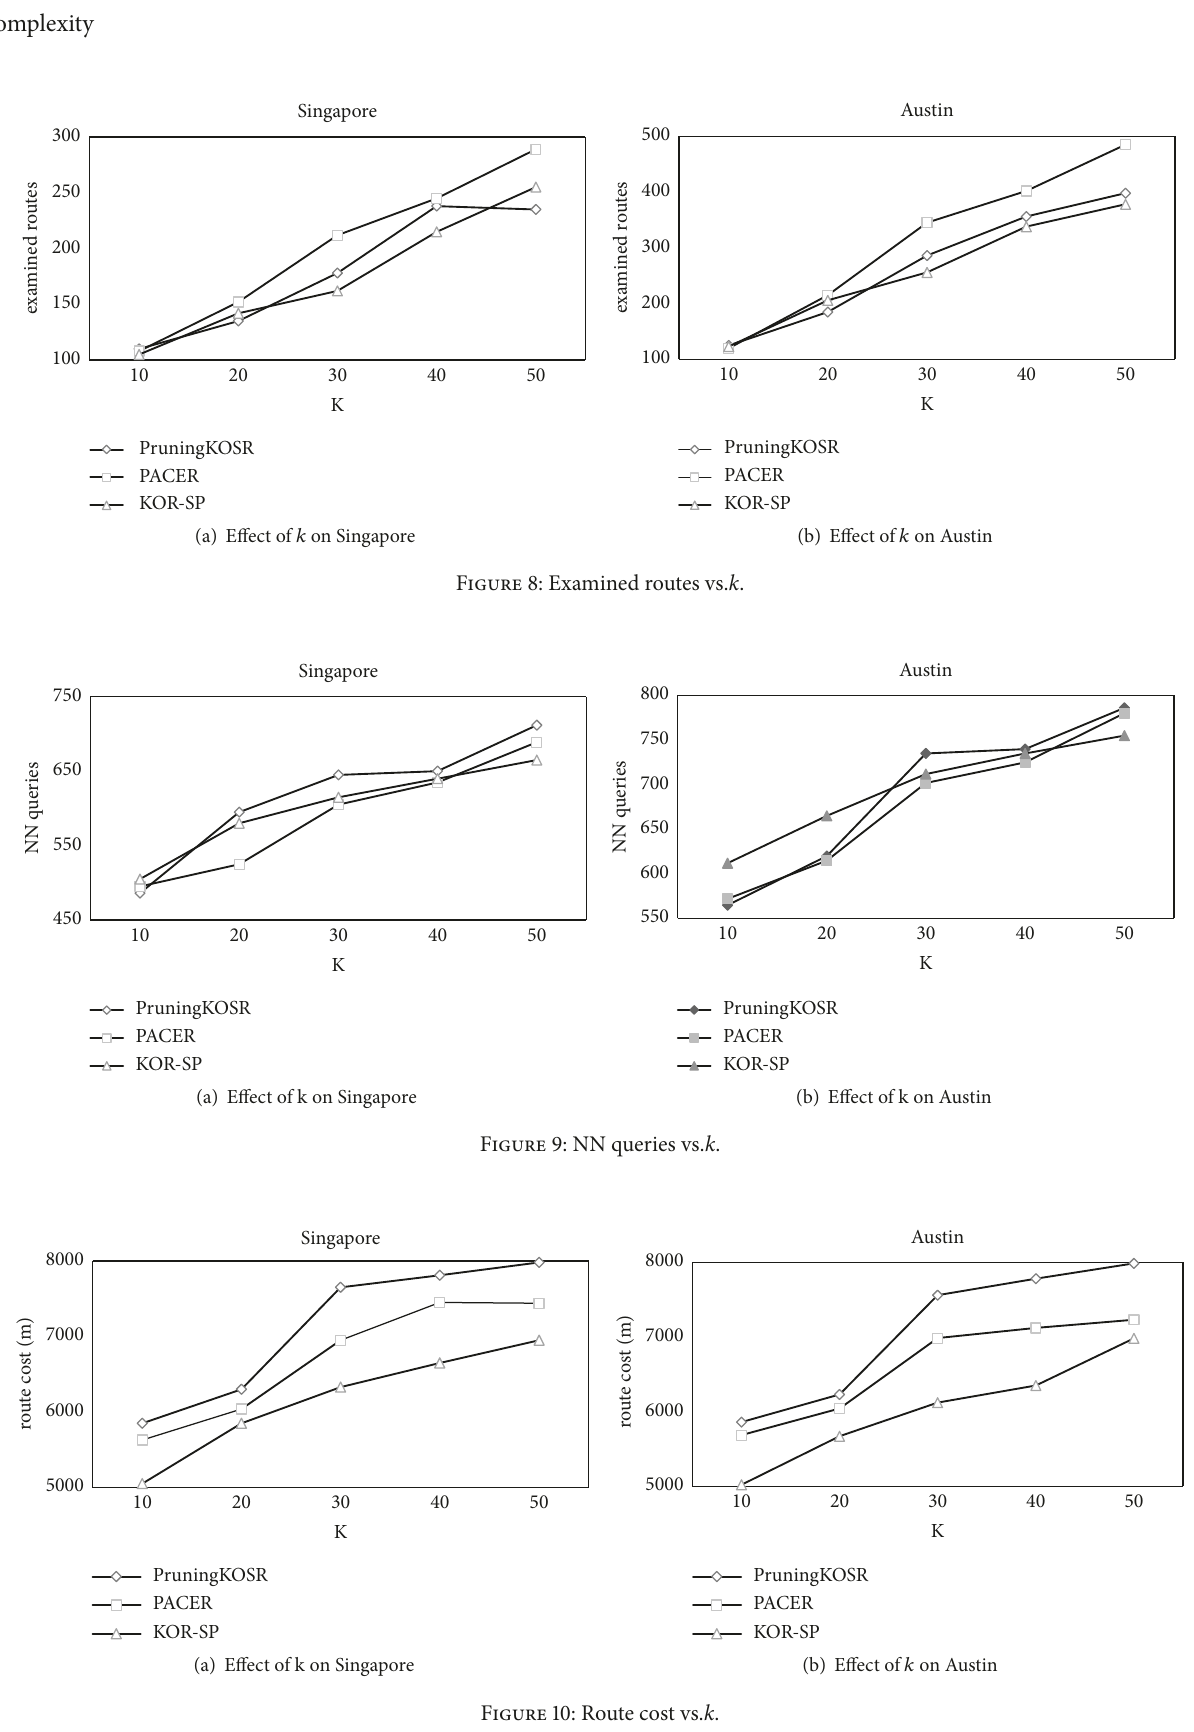
Figure 10: Route cost vs. k